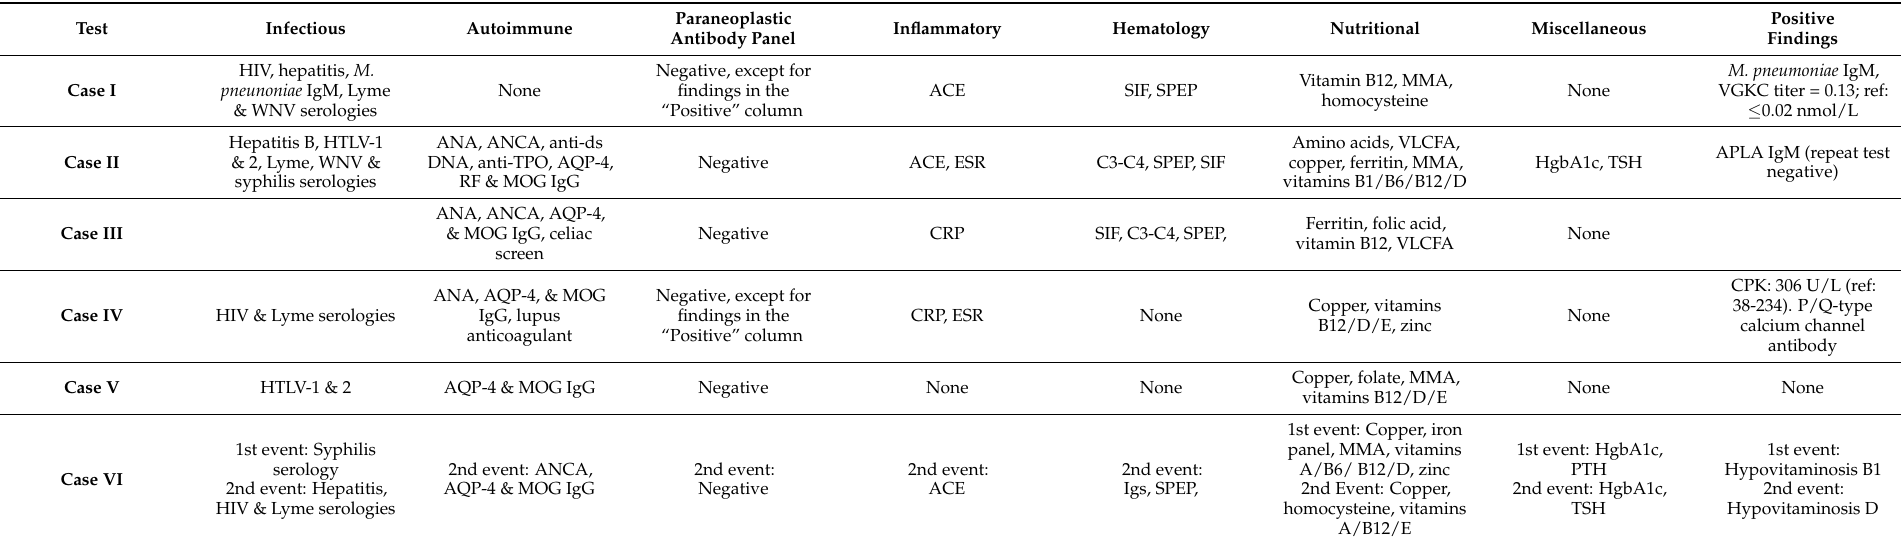
Table 1. Summary of the serum laboratory test results for the six patients. All the columns except the last one (positive findings) reflect all the tests that were performed and were unremarkable. Abbreviations: ACE-angiotensin-converting enzyme, ANA-antinuclear antibody, ANCA-antineutrophil